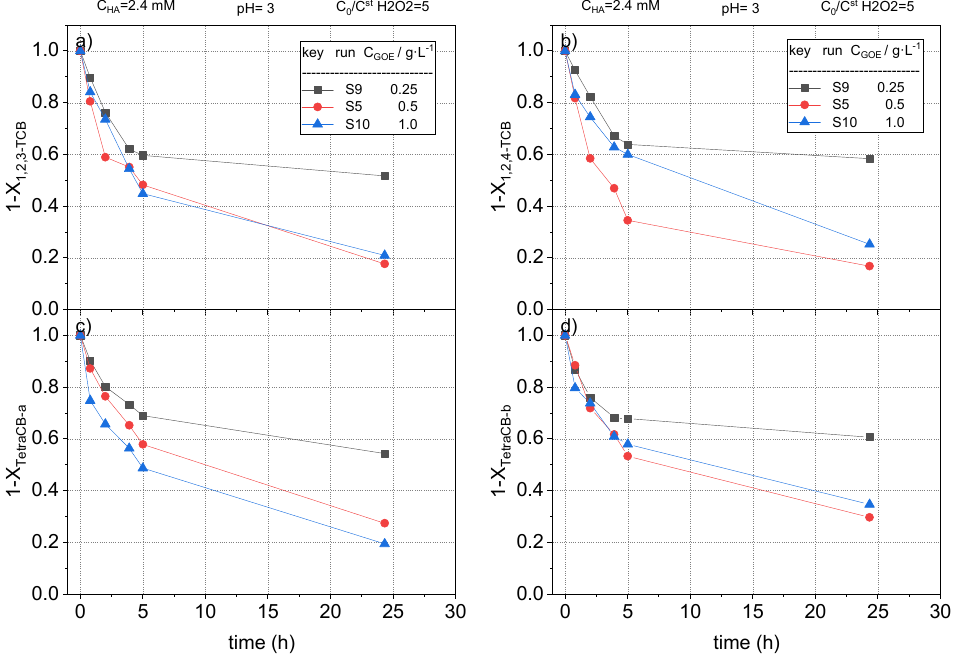
Figure 14. Remaining fractional concentration of ( a ) 1,2,3-trichlorobenzene (1 − 𝑋 (cid:2869),(cid:2870),(cid:2871)(cid:2879)(cid:3021)(cid:3004)(cid:3003) ); ( b ) 1,2,4- trichlorobenzene (1 − 𝑋 (cid:2869),(cid:2870),(cid:2872)(cid:2879)(cid:3021)(cid:3004)(cid:3003) ); ( c ) tetrachlorobenzene-a (1 − 𝑋 (cid:3021)(cid:3032)(cid:3047)(cid:3045)(cid:3028)(cid:3004)(cid:3003)(cid:2879)(cid:3028) ); and ( d ) tetrachlorobenzene-b (1 − 𝑋 (cid:3021)(cid:3032)(cid:3047)(cid:3045)(cid:3028)(cid:3004)(cid:3003)(cid:2879)(cid:3029) ) vs . reaction time at pH 0 = 3, 𝐶 (cid:3009)(cid:3002) = 2.4 𝑚𝑀 and (𝐶 (cid:3009) H 2 O 2 (cid:3118) (cid:3016) (cid:3118),(cid:3116) (cid:3046)(cid:3047) ) = 5 (12.43 𝑚𝑀) , at room temperature (controlled at 22 °C).